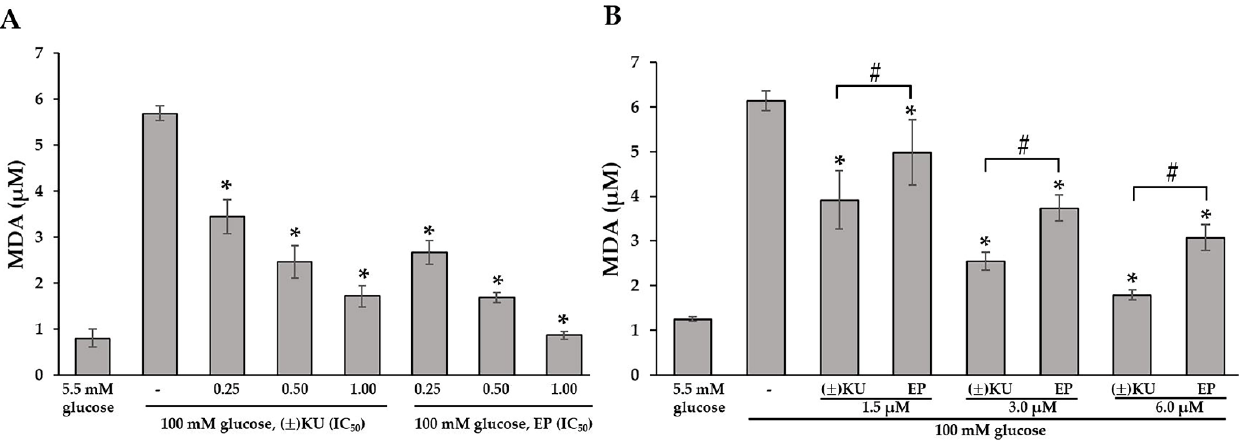
Figure 5 . ( ± ) KU causes the inhibition of lipid peroxidation on Hs578T in high-glucose conditions . Hs578T cells were treated with ( ± ) KU or EP at the indicated concentration for 24 h before being replaced with RPMI medium with or without 100 mM glucose for 1 h . Cells were homogenized and MDA level measured using TBARS assay . ( A ) Quantitative MDA level on Hs578T - pretreated cells with ( ± ) KU and EP at 0 . 25×, 0 . 50× and 1 . 00× IC 50 values of cytotoxicity . ( B ) Quantitative MDA levels on Hs578T - pretreated cells with ( ± ) KU and EP at the same concentration ( 1 . 5, 3 . 0, 6 .0 μ M ). All graphs show mean ± SD with four independent experiments . Statistically significant differences for pretreated cells with various concentrations of ( ± ) KU and EP vs . non - pretreated cells were determined using a one - way analysis of variance followed by Tukey ’ s multiple comparison test (* p < 0 . 05 versus only glucose treatment, # p < 0 . 05 is considered of ( ± ) KU to compare to EP treatment ). ( ± ) KU, trans -( ± )- kusunokinin; EP, epalrestat .